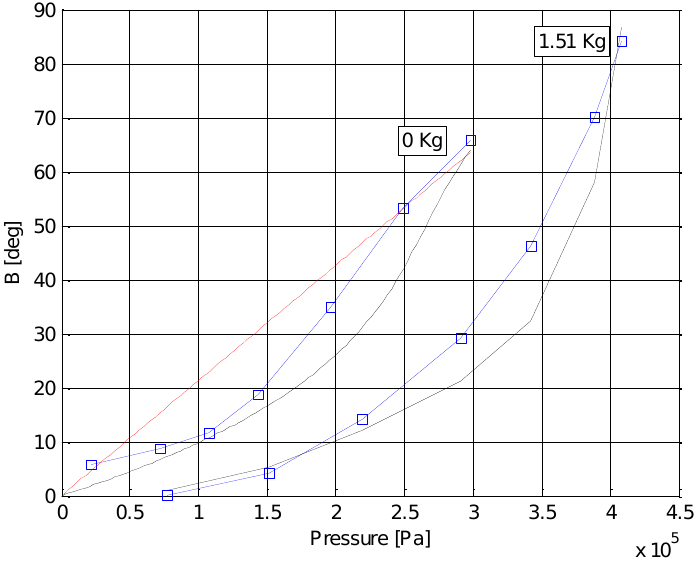
Figure 8. Static response for HELM prototype 3, with and without external loading. The red line presents linear theory with E = 1.709 MPa. The black curve presents nonlinear analysis, while blue squares mark the experiment.